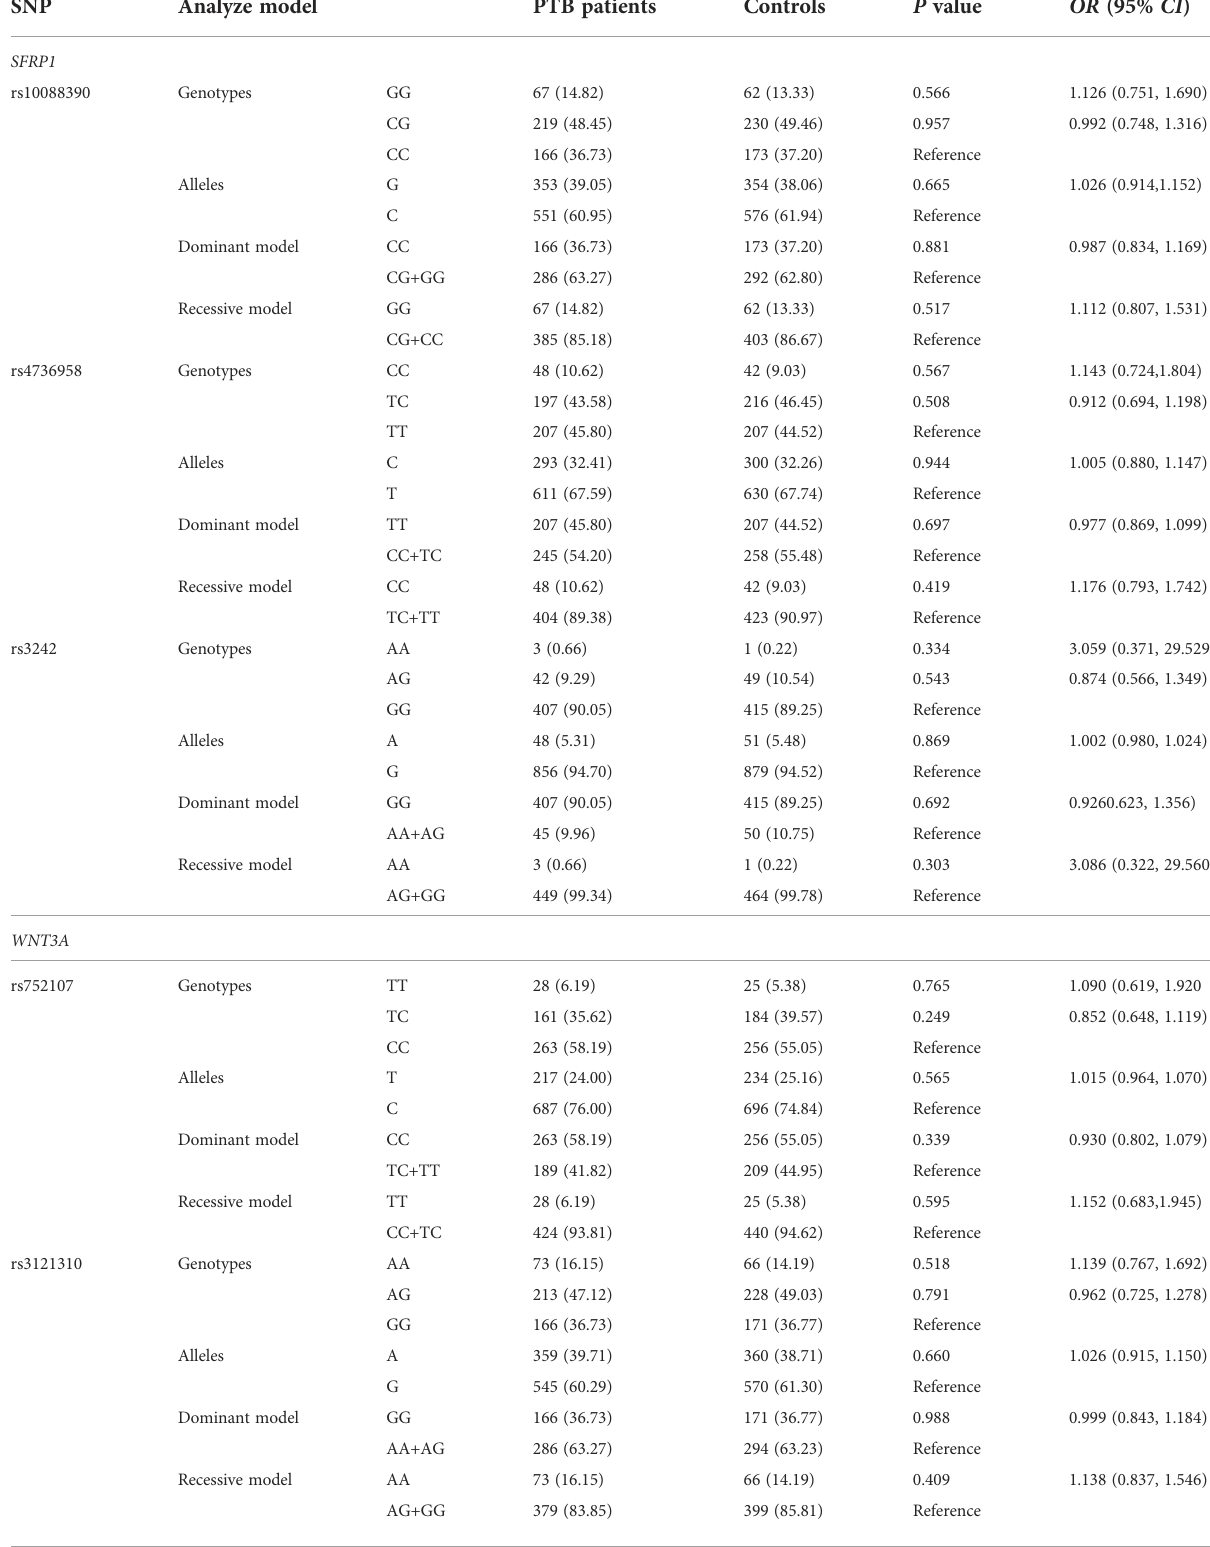
TABLE 1 Comparison of WNT pathway genes variations between PTB patients and